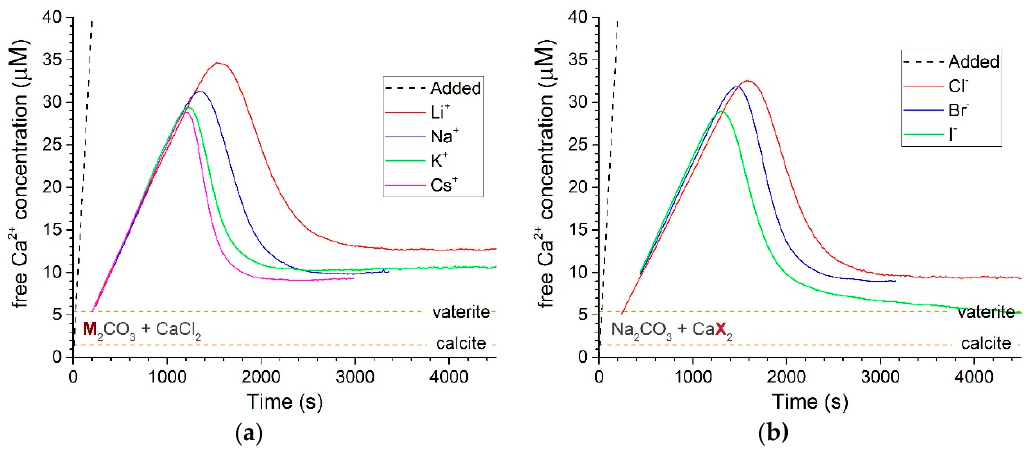
Figure 2. Free-Ca 2+ concentration measured in type I titration experiments for ( a ) different background cations in the carbonate source and ( b ) different background anions in the calcium source. Horizontal orange dashed lines in ( a , b ) show the expected free-Ca 2+ concentration for the different phases according to calculations using the geochemical computer code (PHREEQc) [35]. The nearly vertical black dashed line shows the time evolution of the total amount of calcium dosed during the titration experiment.